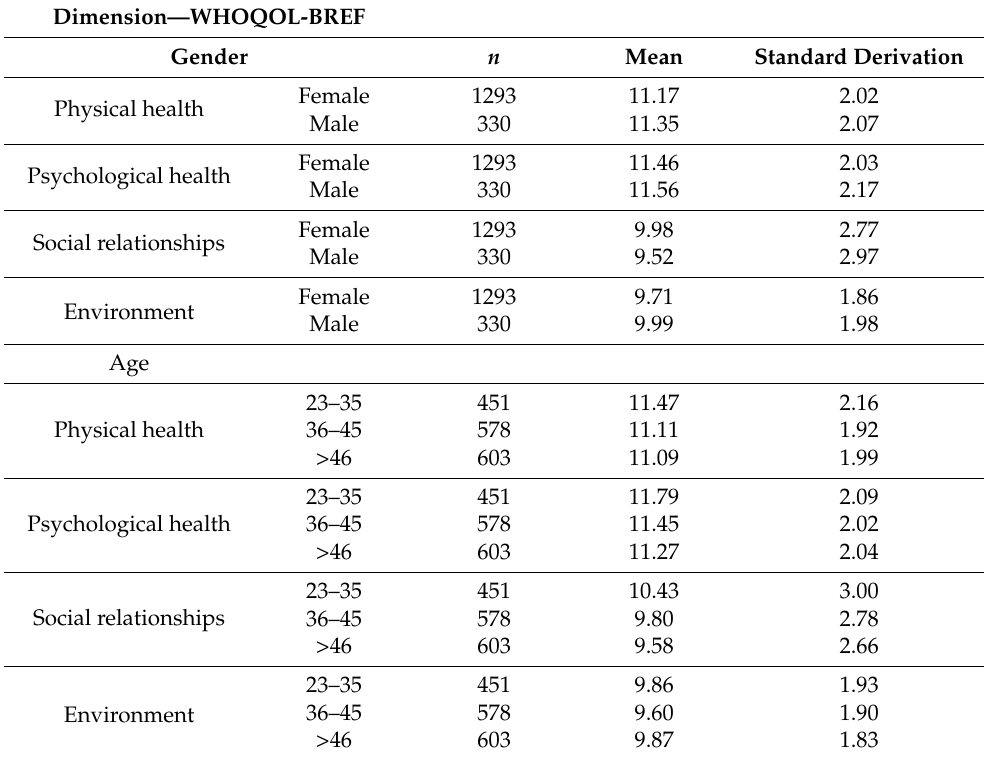
Table 1. Means and standard deviations in quality-of-life scores according to gender and age.